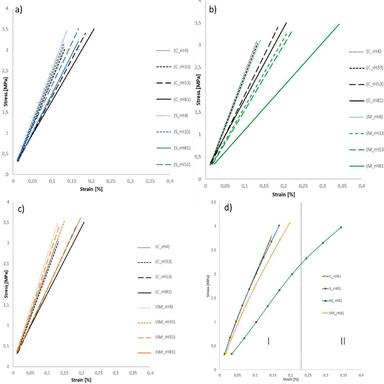
Stress–strain curves of unmodified and modified paper: a) linear regression of paper treated with starch – blue lines; b) linear regression of paper treated with MTMS – green lines; c) linear regression of paper treated with starch modified with MTMS – orange lines; d) paper with different water content in high relative humidity conditions (r.H. 81): I) elastic strain; II) plastic strain. Untreated cellulose as control is depicted as black lines. (For interpretation of the references to colour in this figur